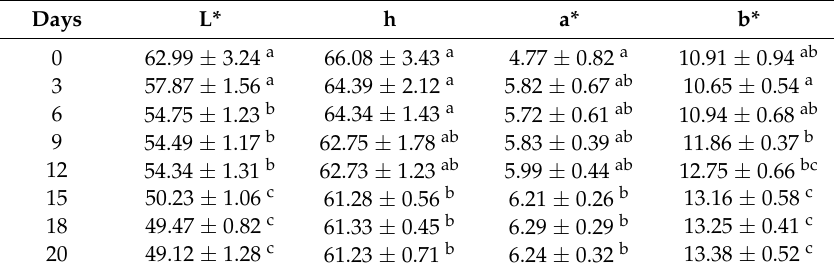
Table A2. Color parameters of smoked turkey hams during refrigerator storage.